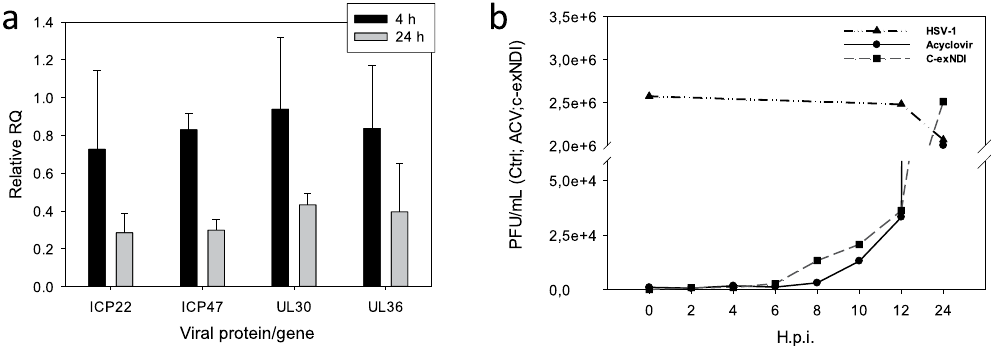
Figure 4. Antiviral effects of c-exNDI. ( a ) Effect of c-exNDI on mRNA levels of immediate-early (IE), early (E) and late (L) proteins of HSV-1. Infected cells were treated with c-exNDI (100 nM); 4 or 24 h.p.i total RNA was isolated, retrotranscribed into cDNA and expression of specific genes was determined by RT-PCR. RQ are Relative Quantities. Each gene was analyzed in duplicate. In all data sets: n ≥ 2, mean ± s.d., Student’s t-test, p ≤ 0.01. ( b ) Effect of c-exNDI on HSV-1 cycle steps evaluated by time of addition assay. C-exNDI was tested at 100 nM (dashed line/squares), acyclovir (ACV) was used as a reference drug and tested at 3 μ M (solid line/ circles). Data from infected cells treated in the same conditions but without the compounds are reported as dashed line/triangles. Compounds were administered from 0 to 12 h.p.i. and supernatants were collected 30 h.p.i. The left and right Y-axis refer to ACV and c-exNDI data,